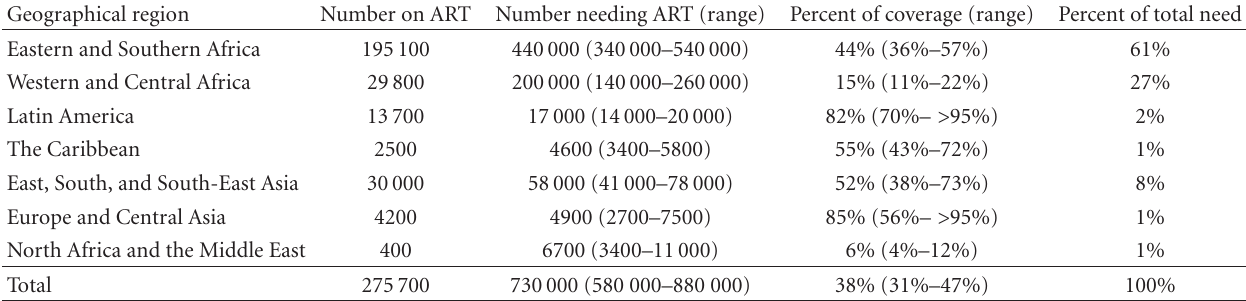
Table 1: Antiretroviral therapy coverage among HIV-infected children less than 15 years of age in resource-limited countries, December